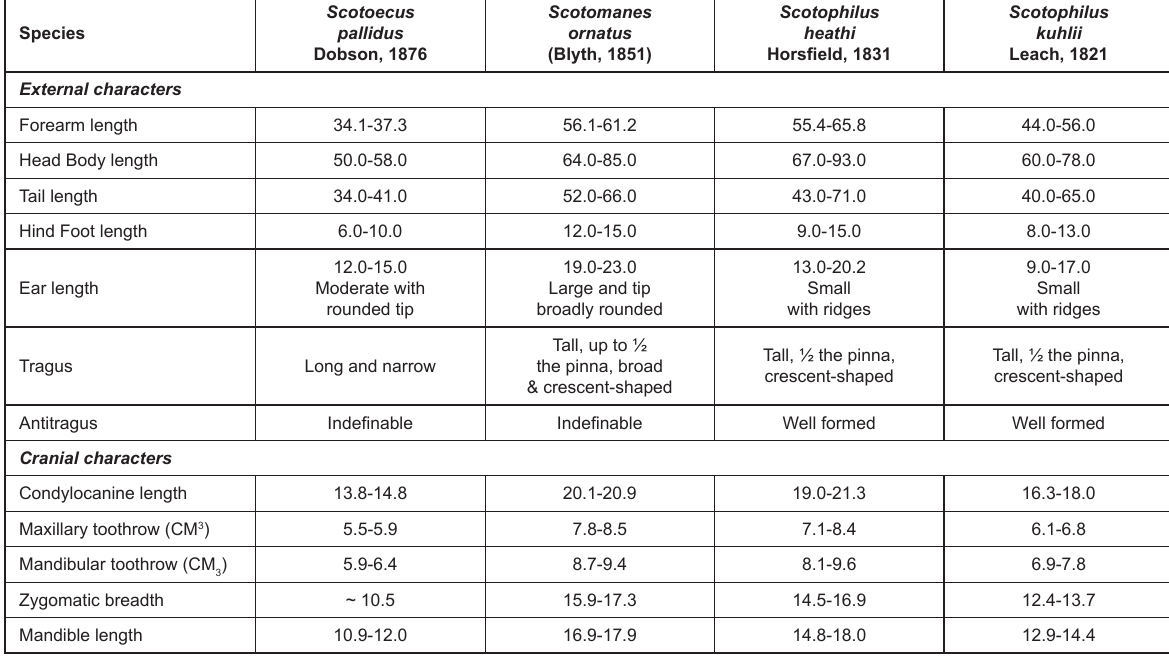
Table 7.5. Diagnostic morphological characters of the species belonging to the genera Scotoecus , Scotomanes and Scotophilus present in South